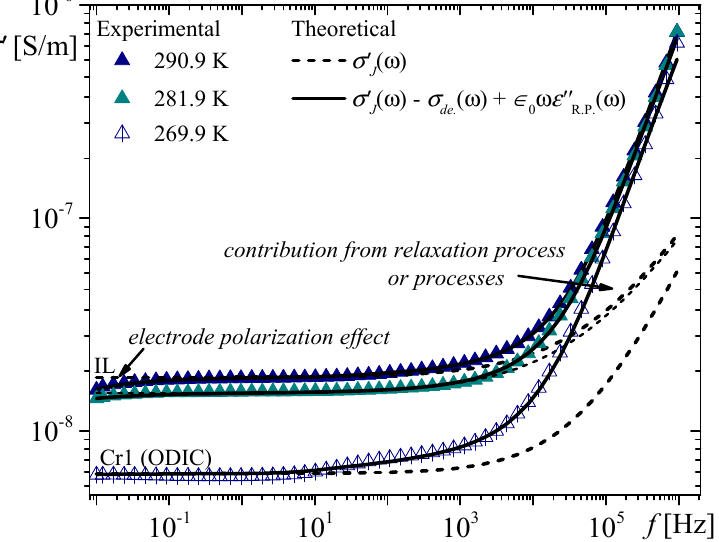
Figure 1. Real part of dielectric conductivity for 33DM2B in IL phase (at 290.9 K, 281.9 K and Cr1 phase (269.9 K).